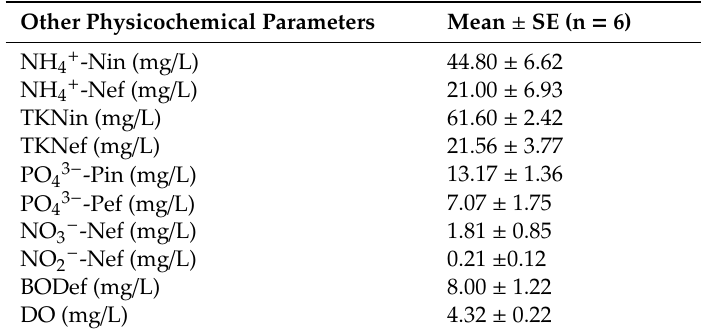
Table 1. Determination of other physicochemical characteristics in the influent and the e ffl uent of the immobilized cell biofilter treating diclofenac-based